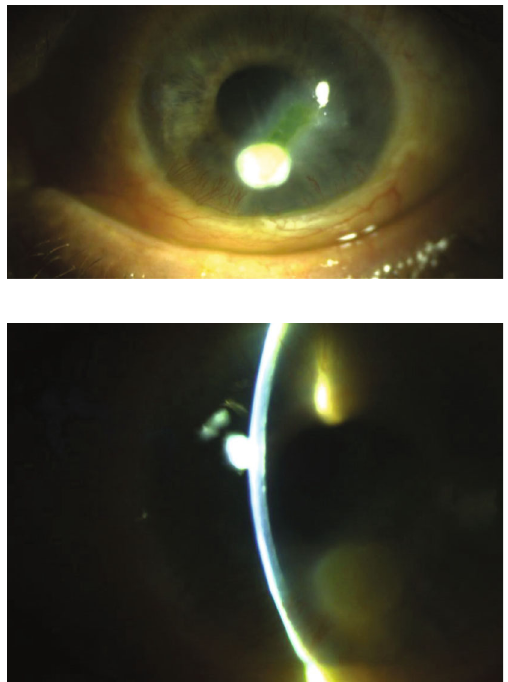
Figure 1: Bacterial keratitis at presentation.